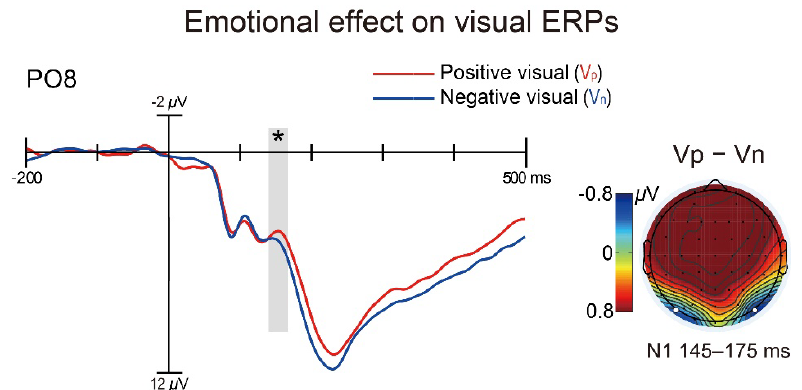
Figure 4. ERP waveforms elicited by emotionally positive visual-only (blue lines: V p ) and negative visual-only (green lines: V n ) stimuli, exemplified from the right occipital electrode PO8. The shaded area on waveforms depicts the time window of 145–175 ms within which the visual N1 component was measured. The scalp topography is shown for positive visual-only minus negative visual-only mean difference amplitudes during the visual N1 interval. The amplitude of N1 was larger for positive visual-only than negative visual-only stimuli. *: p < 0.05 for the contrast.